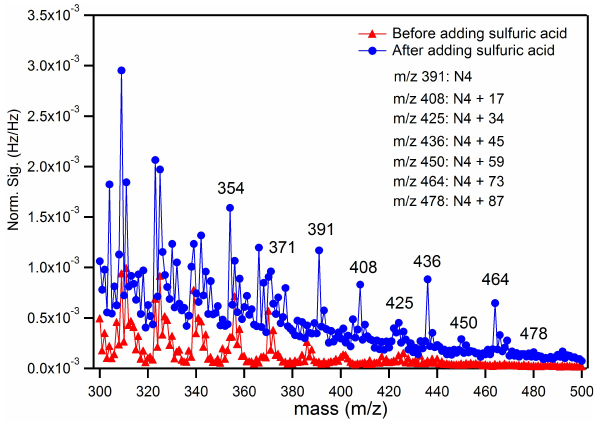
Fig. 2. Comparison of typical spectral scan (negative ions) from m/z 300–500amu between before (red) and after (blue) addition of ∼ 3 × 10 8 cm − 3 sulfuric acid into the Cluster CIMS inlet. The res- idence time is ∼ 9s. The peaks corresponding to m/z 354 and 371 are possibly some sulfur related compounds. Peak of m/z 391 is assigned to be tetramer (N4) and m/z 408, 425, are clusters con- taining 4 H 2 SO 4 molecules plus one or two ammonia molecules, respectively. Peaks corresponding to m/z 436, 450, 464, 478 are clusters containing 4 H 2 SO 4 molecules plus one amine molecule. The masses of the amines are 45, 59, 73, and 87amu respectively. Norm. Sig. is the individual signal divided by the total signal, sum- ming over the reagent ions ( m/z 125 and 188). Measurements were carried out at the Foothills laboratory of NCAR in Boulder, Col-